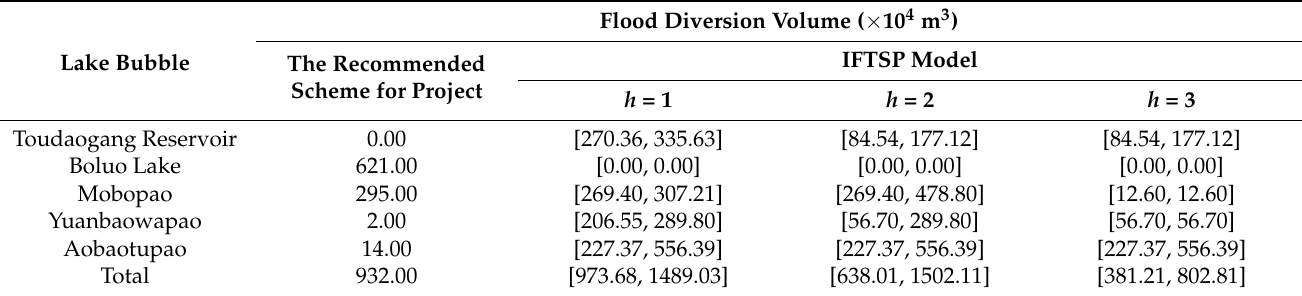
Table 3. Flood diversion volumes of each of the lake bubbles in the Boluo Lake under different